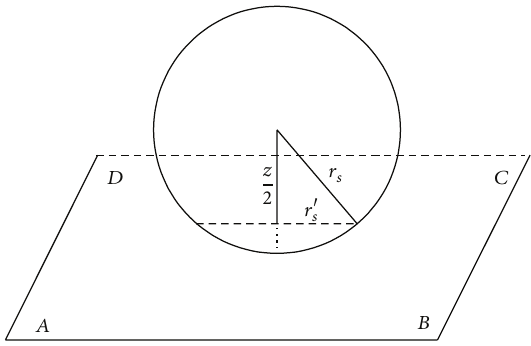
Figure 2: Coverage radius 𝑟 󸀠 𝑠 in plane 𝐴𝐵𝐶𝐷 .